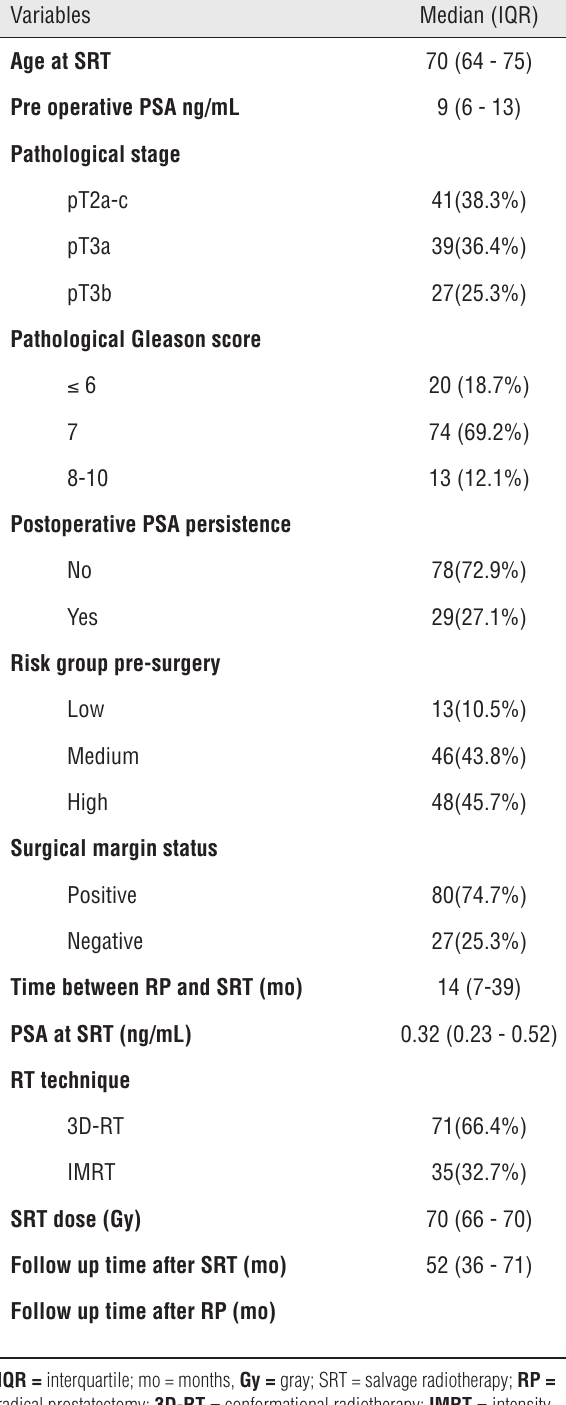
Table-1 - Descriptive characteristics of 107 patients undergoing radical prostatectomy (RP) with rising PSA after surgery and submitted to salvage radiotherapy